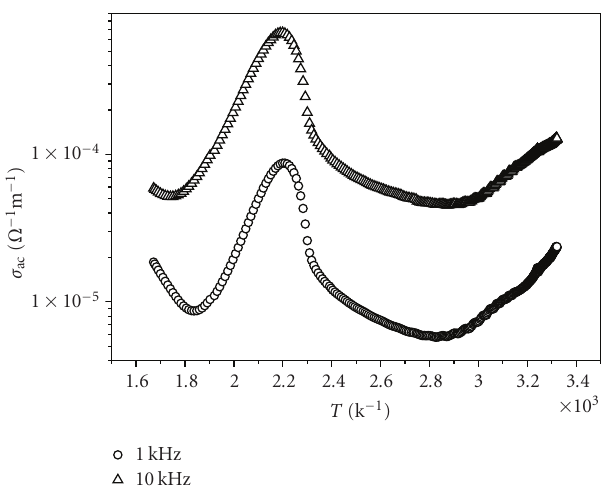
Figure 2: Variation of AC conductivity with 10 3 /T at 1 and 10 kHz of PMN-35PT. Measurement performed during